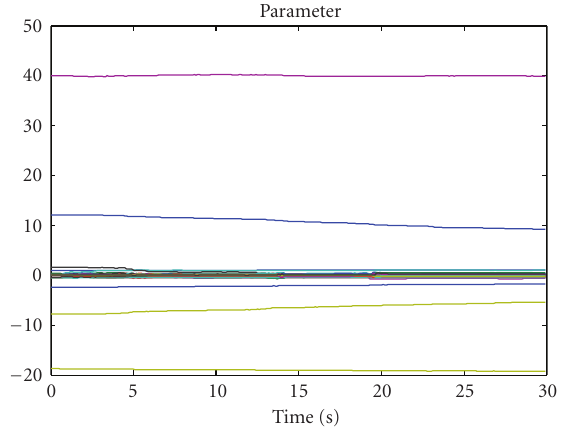
Figure 10: Convergence of parameter estimation of NARMAX model using RELS method with